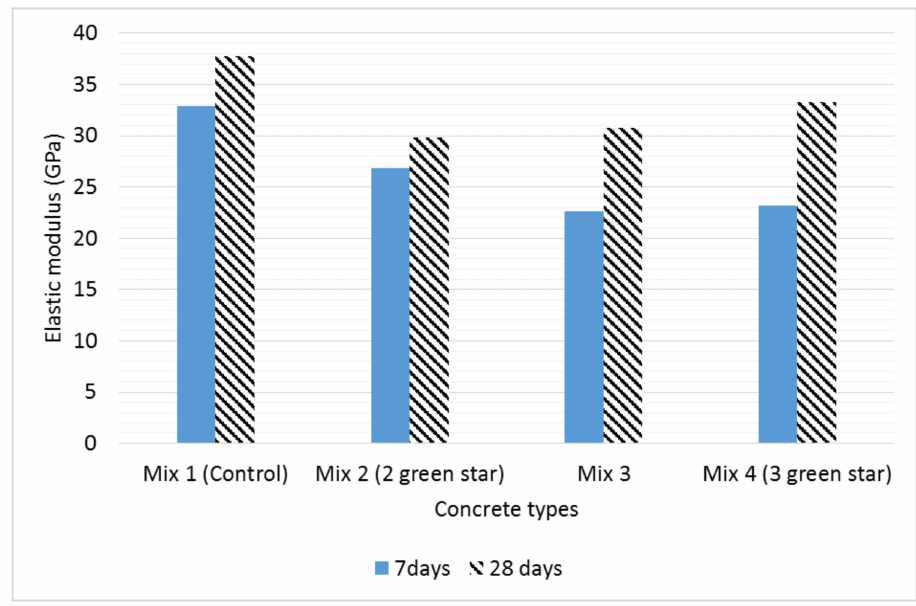
Figure 6. Measured elastic modulus of green star concretes and control